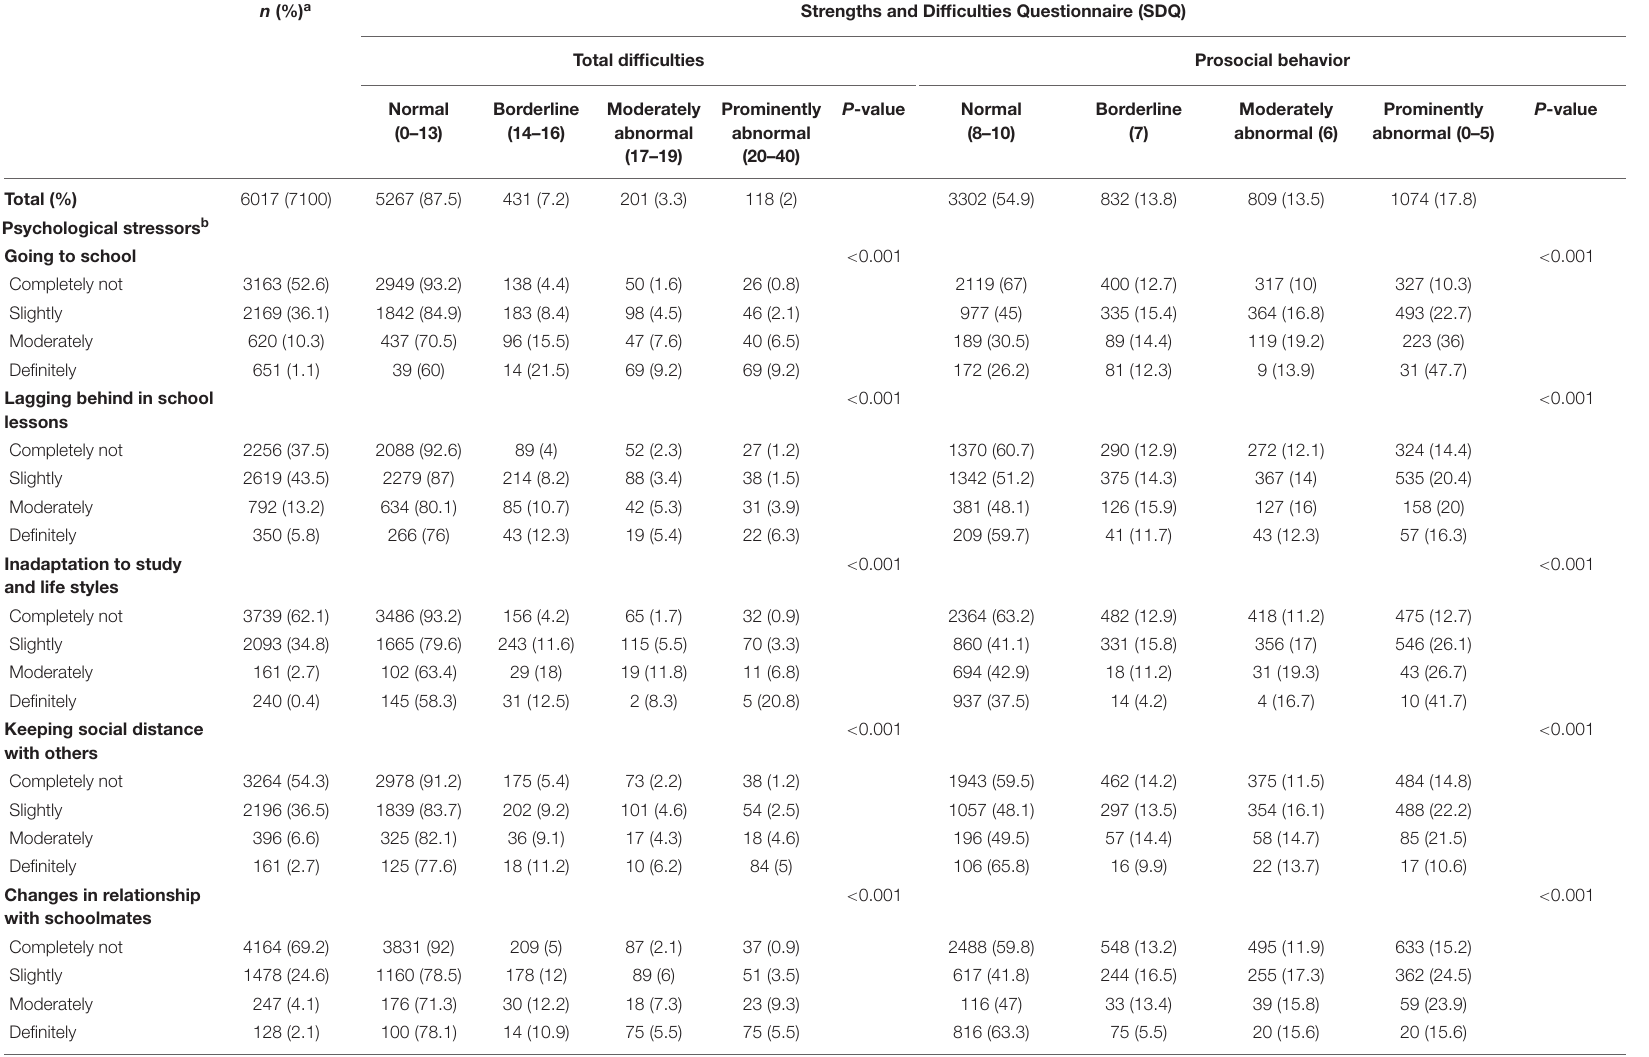
TABLE 2 | Distributions of total difficulties score and prosocial behavior score by psychological stressors, daily activities, and social